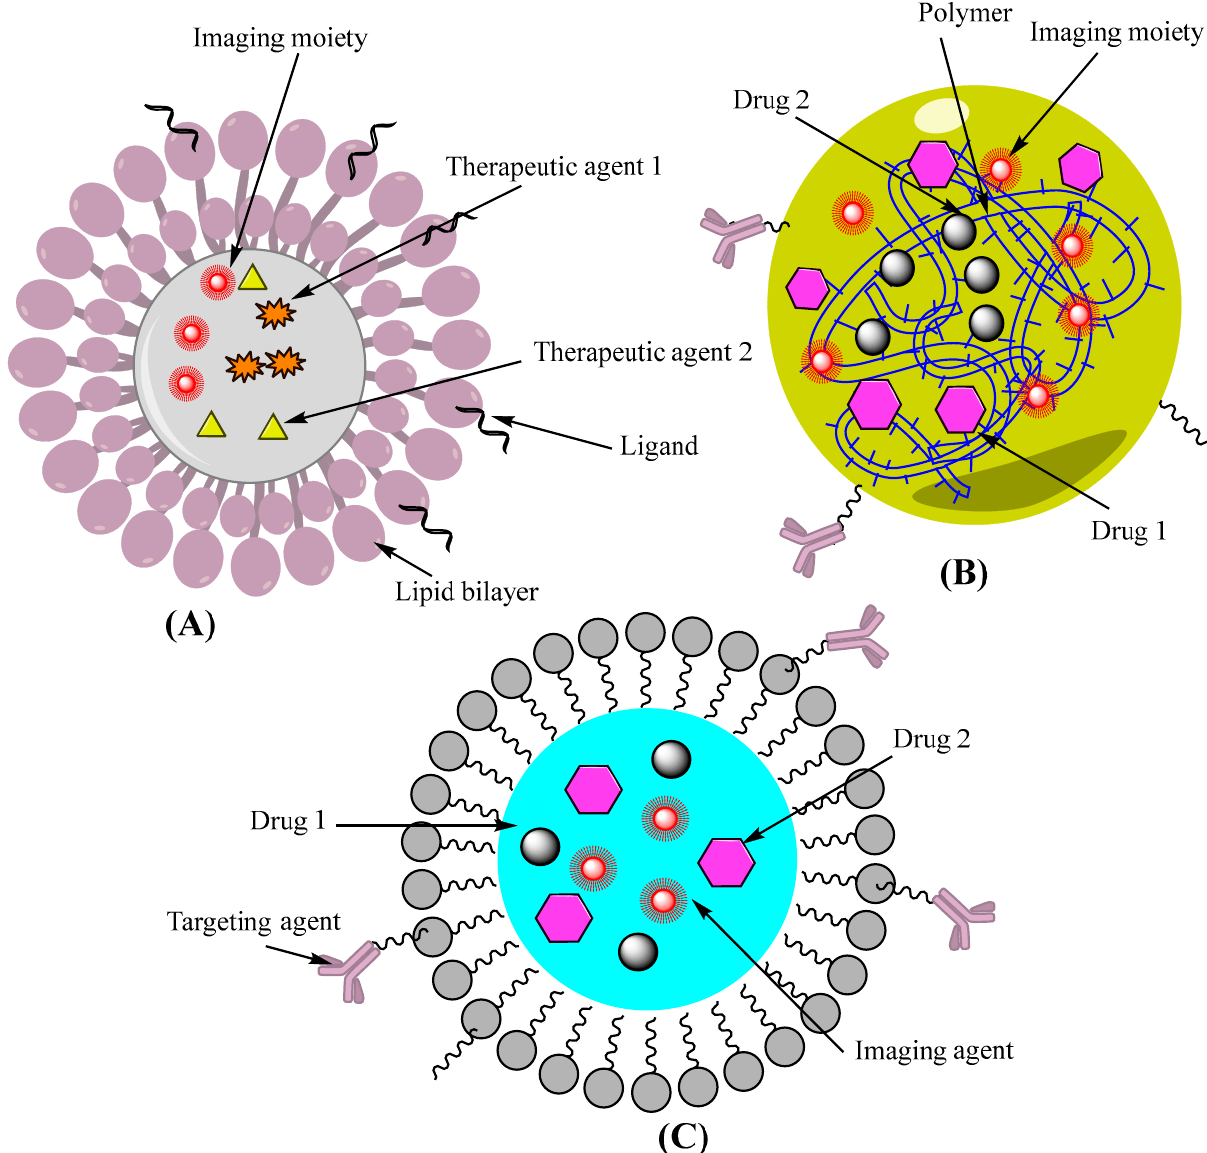
Figure 5. Schematic representation of combination therapy approaches in targeting lung cancer. ( A ) Combination lipid nanoparticles with imaging and therapeutic moiety ( B ) Polymer based nanocapsule hybrid therapy with imaging and targeting moiety along with therapeutic agent ( C ) Inorganic ‐ polymer combination nanoparticle coencapsulated with drug molecule, targeting agent and imaging moiety.